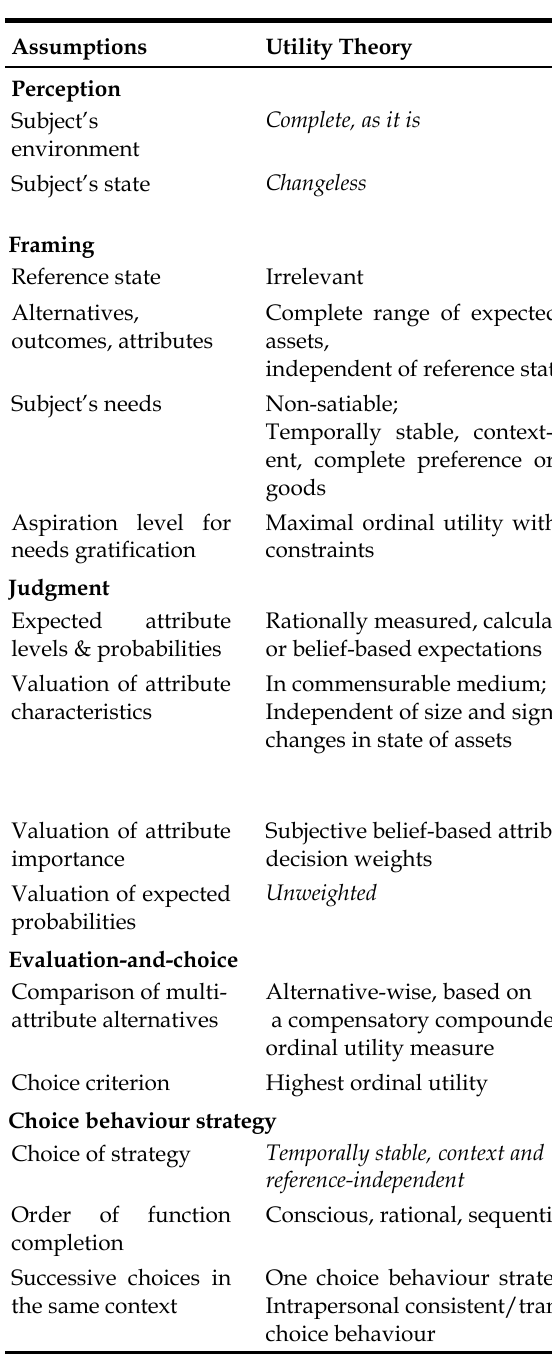
Table 1. Assumptions of UT and PT in a functional-descriptive